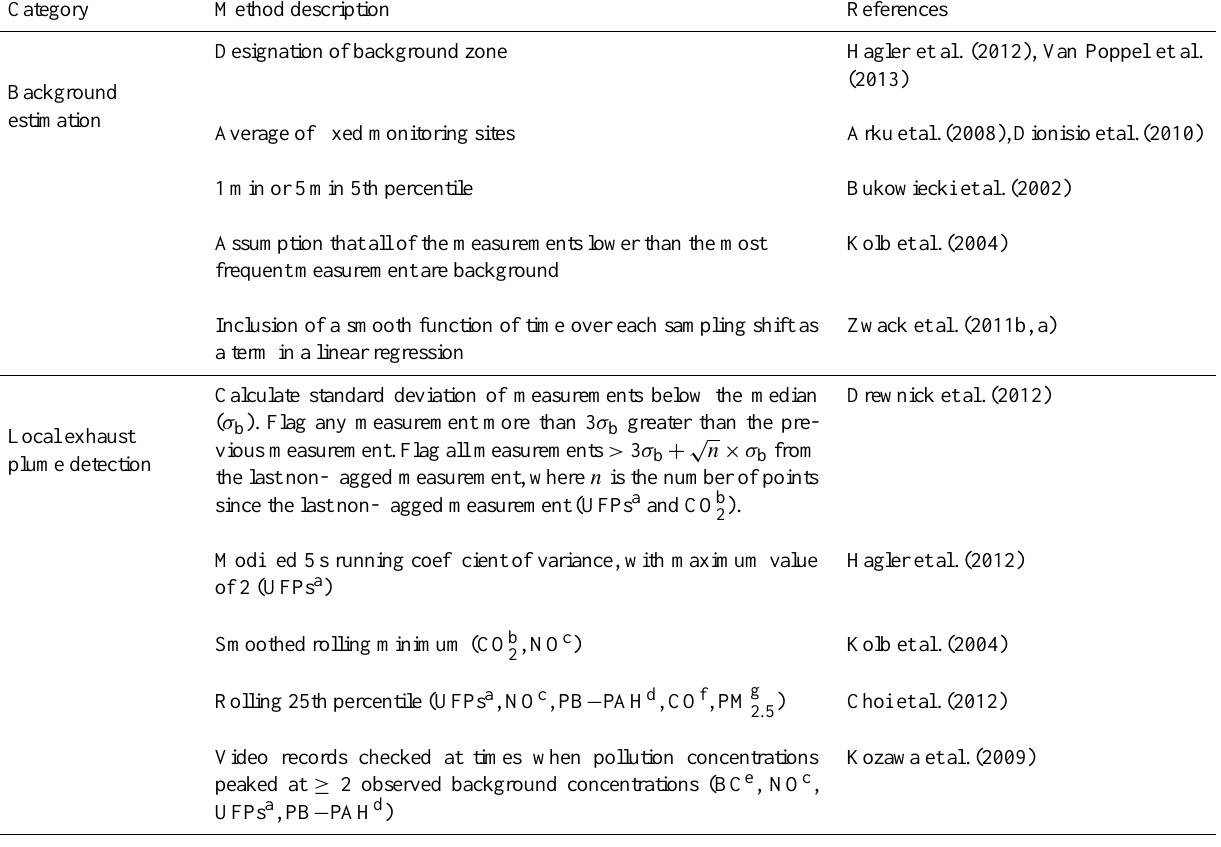
Table 2. Mobile data-processing methods.